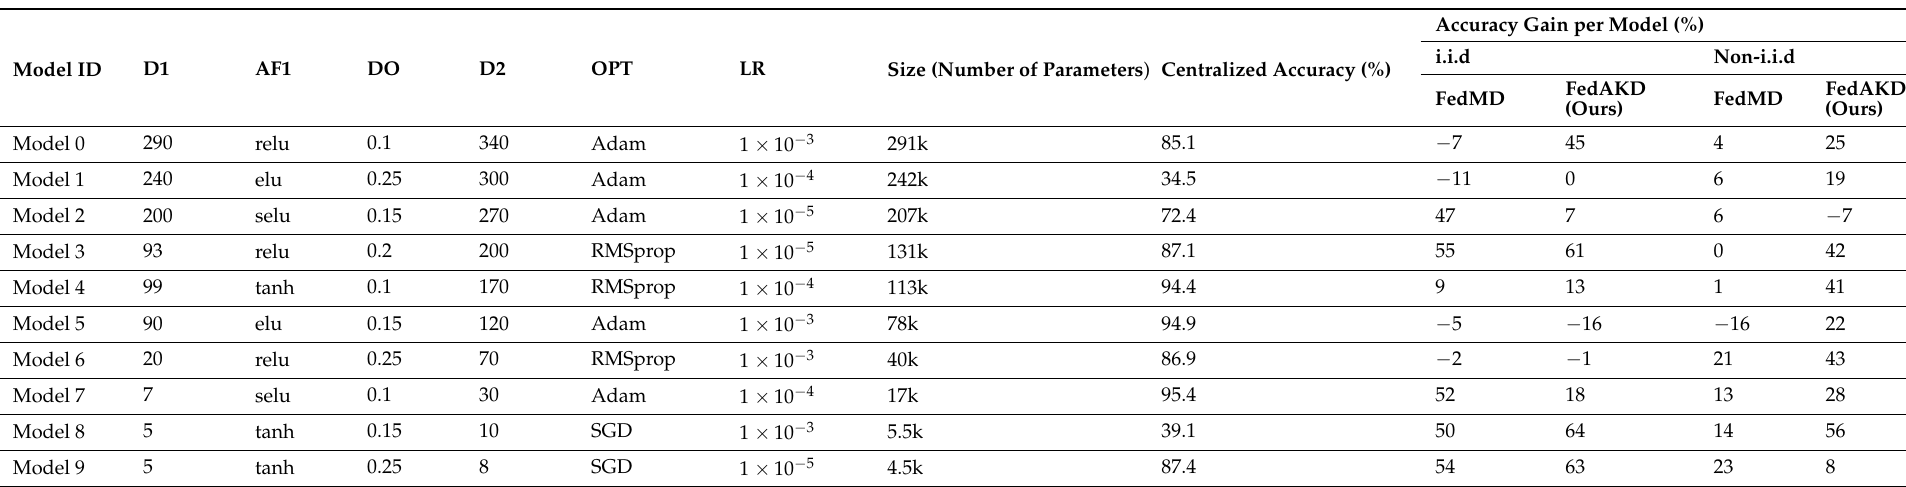
Table 4. Architecture details of the deep learning models participating in the HARS dataset FL